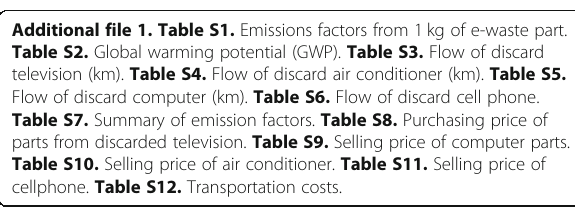
Table S7. Summary of emission factors. Table S8. Purchasing price of parts from discarded television. Table S9. Selling price of computer parts. Table S10. Selling price of air conditioner. Table S11. Selling price of cellphone. Table S12. Transportation